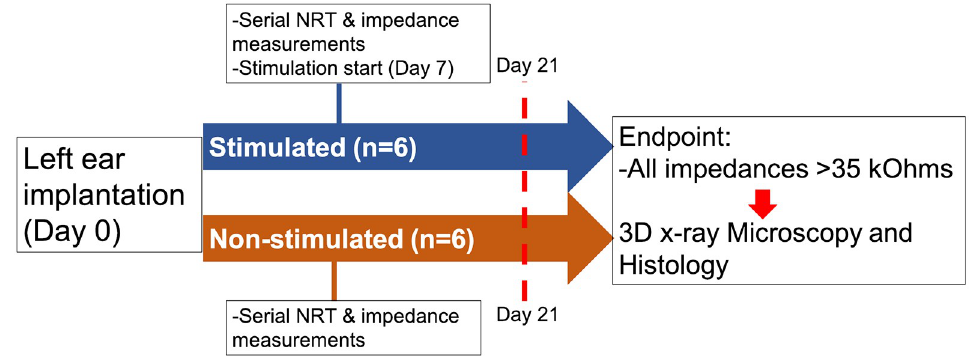
Fig 1. Experimental time course. Left ear cochlear implantation was performed in both the stimulated (n = 6) and non- stimulated (n = 6) groups. Serial NRT and impedance measurements began on post-operative day 7 in both groups. Electric stimulation started in the stimulated group on post-operative day 7. After post-operative day 21 and when all electrodes lost functionality (impedance > 35kOhms), cochleae were harvested for 3D x-ray microscopy and histology.